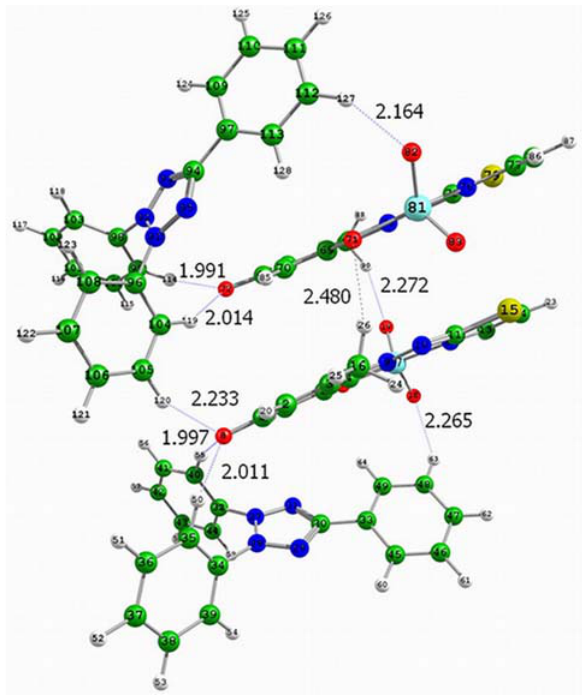
Figure 8. Optimized ground-state equilibrium geometry of the di- mer D .